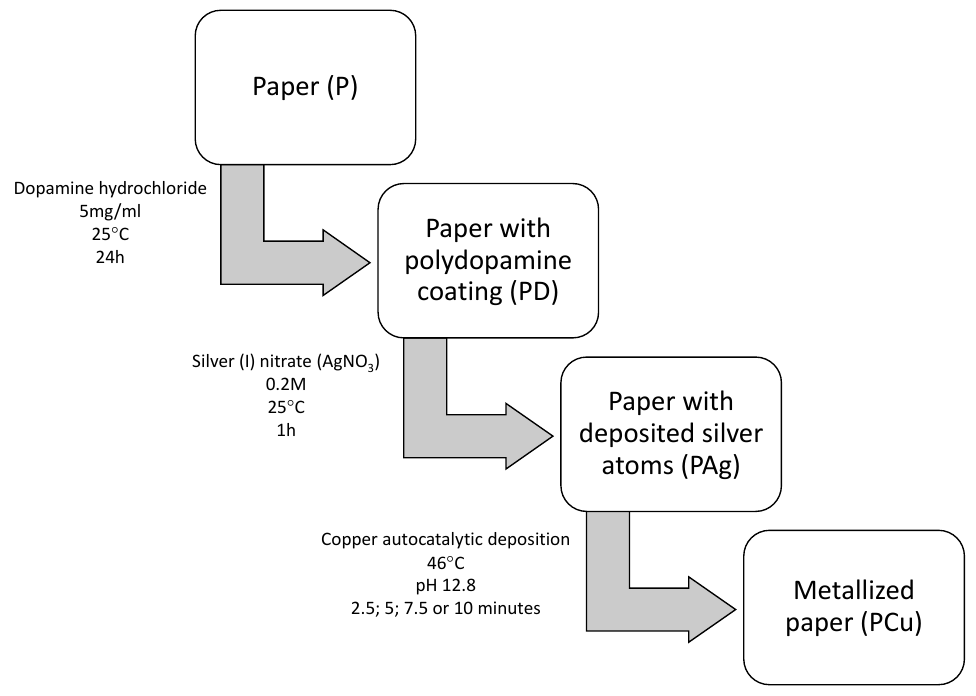
Figure 1. Flow diagram of paper metallization process.